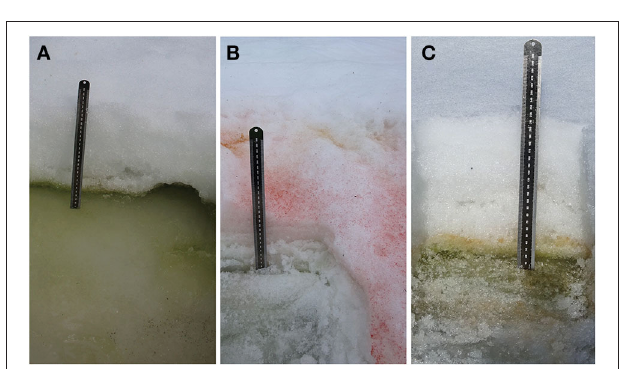
FIGURE 2 | Snow algae pits. Photographs showing (A) a green bloom underneath seasonal snow layer. Lagoon Island, January 12, 2018; (B) a red bloom on the surface of seasonal snow. Léonie Island, January 30, 2018; (C) red algae emerging on top of band of green snow algae. Anchorage Island, February 9,